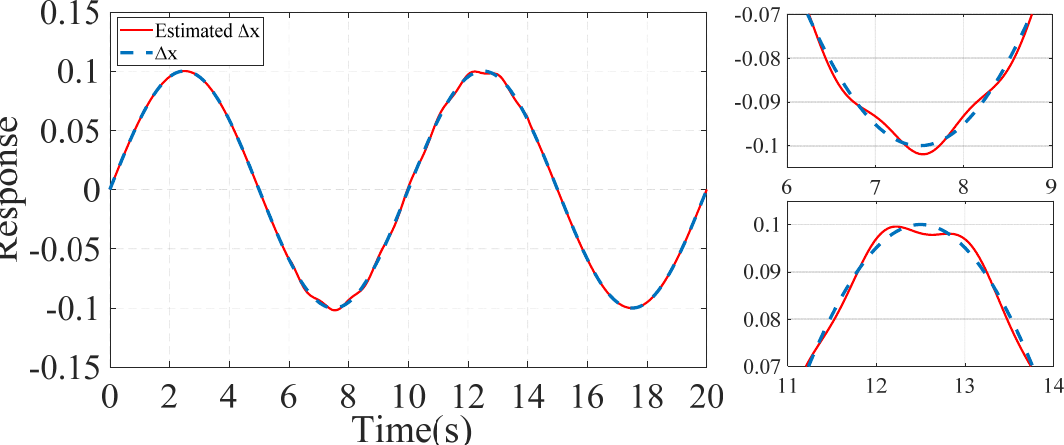
Figure 10. Comparison between the estimated ∆ ˆ x and ∆ x .